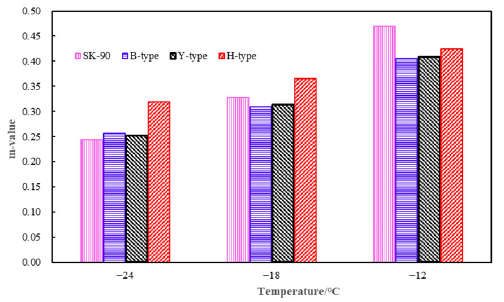
Figure 8. m-value of di ff erent asphalt binders.